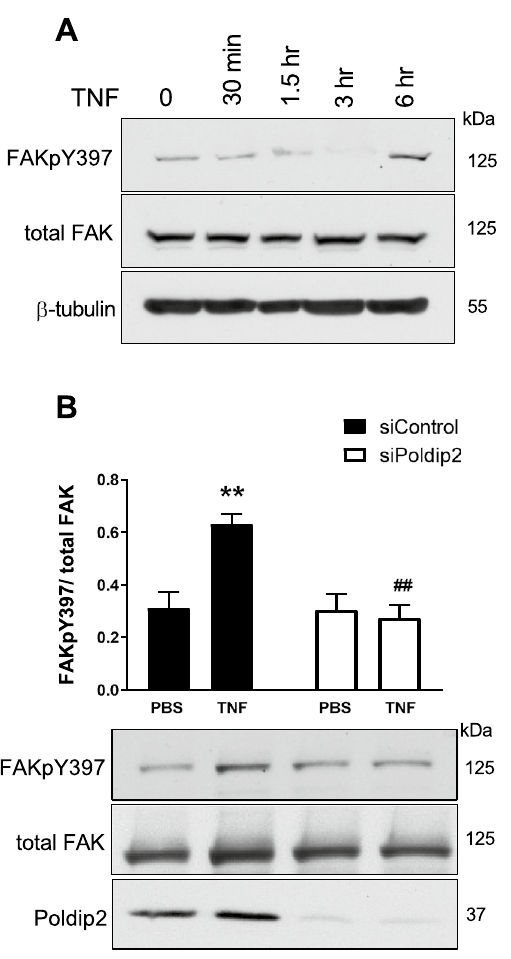
Figure 4. Poldip2 mediates TNF-induced FAK phosphorylation. ( A ) Confluent RBMECs were exposed to TNF (10 ng/ml) for 30 min, 1.5, 3 and 6 h. FAK phosphorylation on Y397 (FAKpY397), total FAK and β-tubulin protein levels were evaluated by western blotting. ( B ) Confluent RBMECs were transfected with siControl or siPoldip2 before exposure to PBS or TNF (10 ng/ml) for 6 h. FAKpY397, total FAK and β-tubulin protein expression were measured by western blotting and densitometry. Down-regulation of Poldip2 after siRNA knockdown was verified by western blotting. Bars represent means ± SEM of 3–5 independent experiments normalized to total FAK. Two-way ANOVA **P < 0.01 vs. siControl PBS and ## P < 0.01 vs. siControl